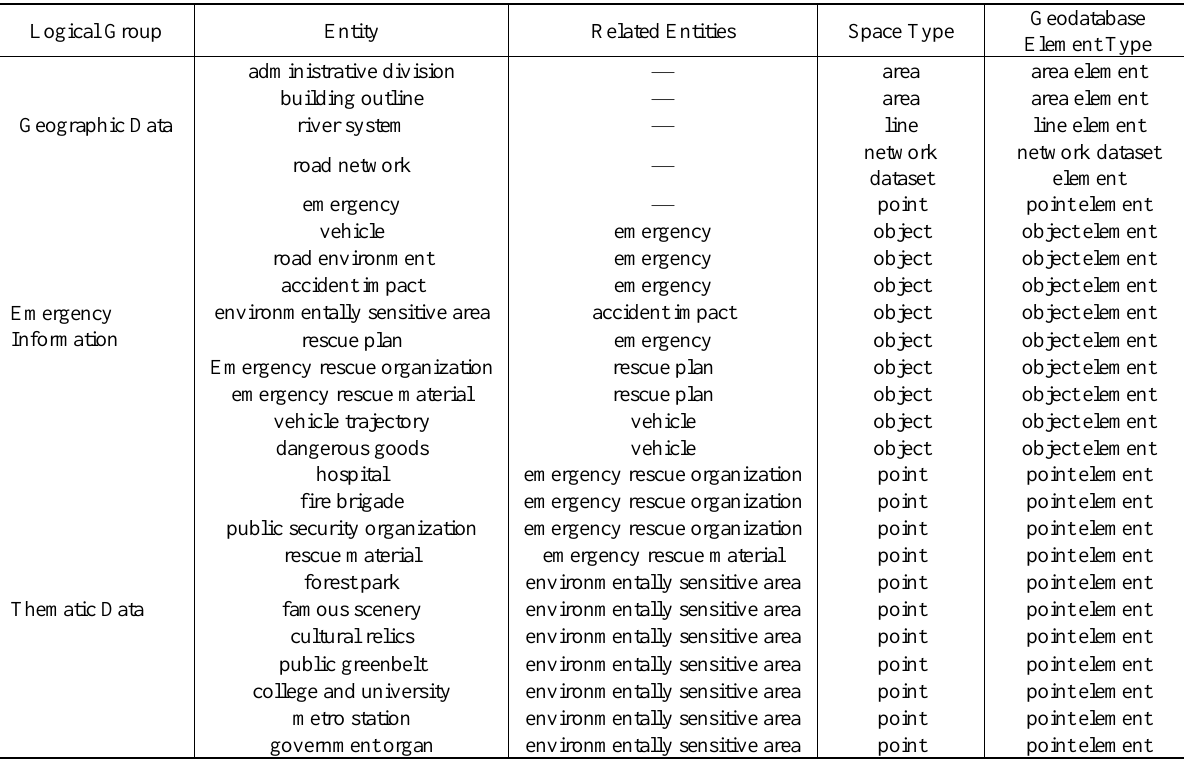
Table 1. Entity and its element type match.